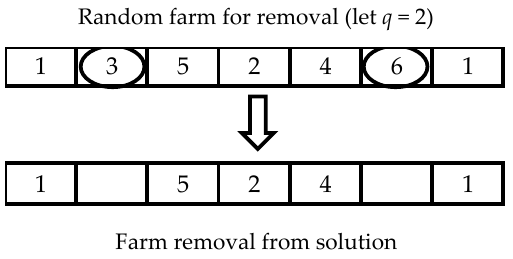
Figure 2. Example of two random removals.